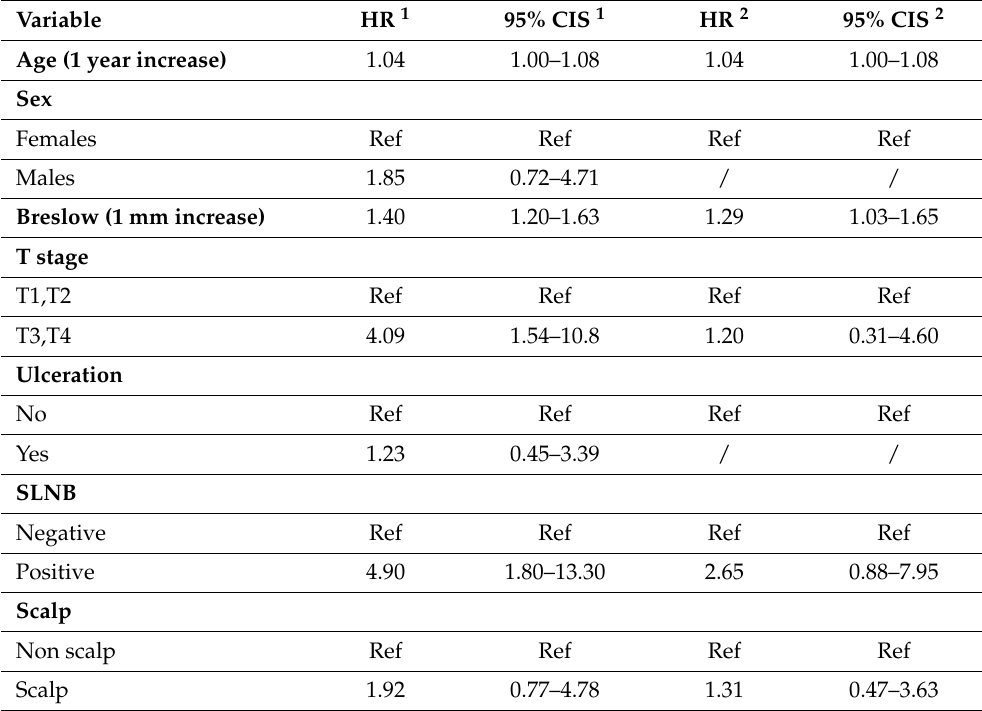
Table 2. Univariate Cox Regression Analysis on relapse-free